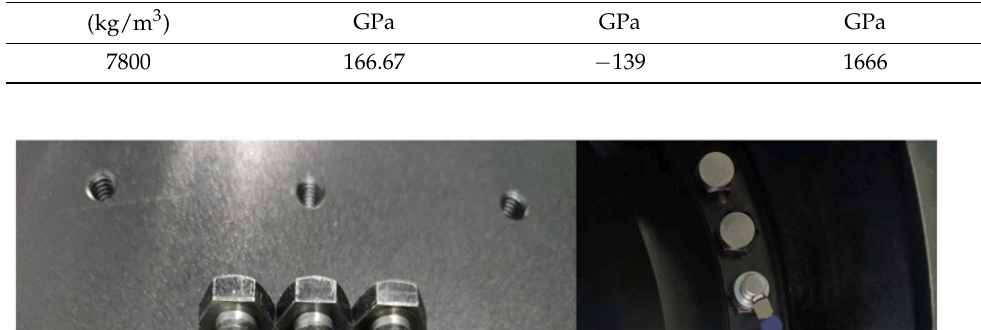
Table 3. Specimens’ material properties: density, ρ ; bulk modulus, κ ; second-and third-order single- crystal anisotropy coefficients, ν and η .